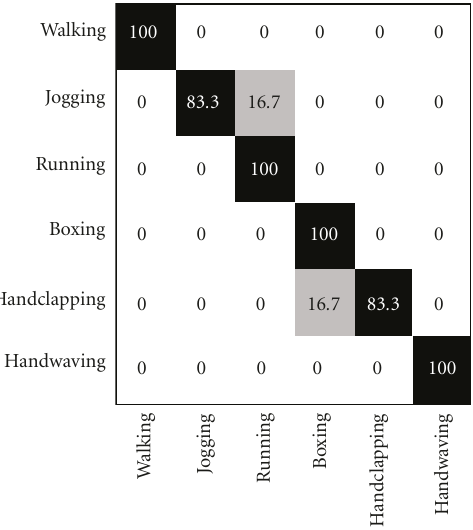
Figure 7: Confusion matrix achieved by our Unsupervised classi- fication algorithm with MMD on KTH human action dataset. The overall accuracy rate of 94.4% is achieved with this method.